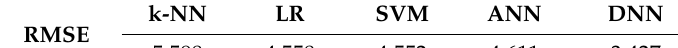
Table 4. RMSE of the SoH estimation by using DNN and traditional machine learning algorithms. k-NN LR SVM RMSE